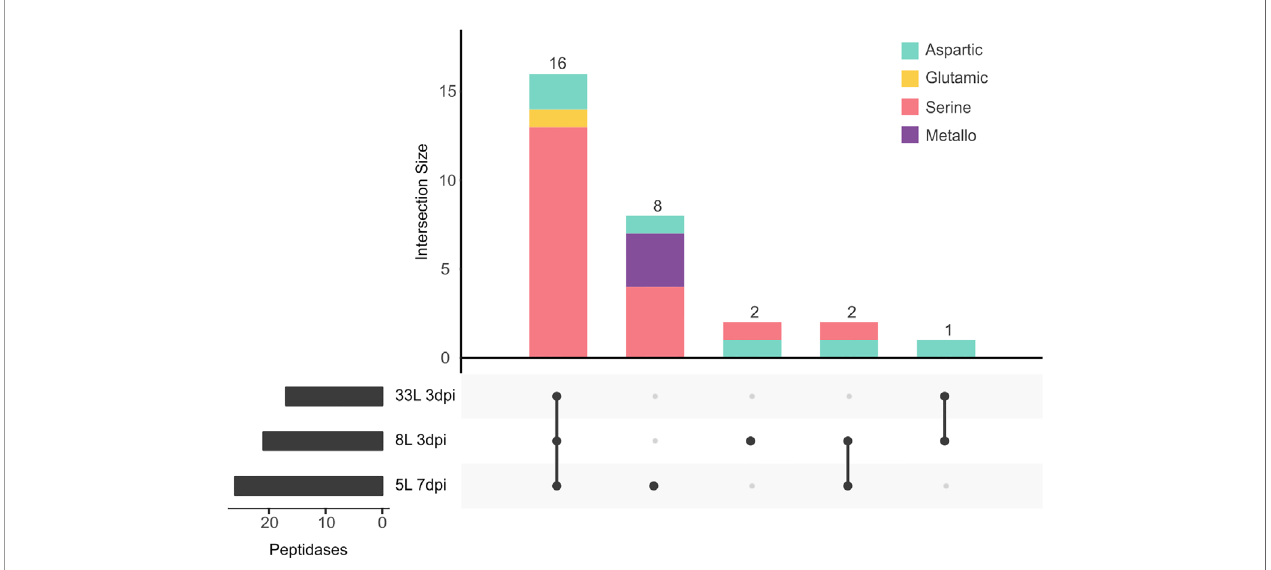
FIGURE 5 | UpSet plot of intersecting sets of peptidase proteins found in exoproteomes. Total identi fi cations for each sample (left bar chart), were 17 proteins for 33L and 21 proteins for 8L at 3 dpi, and 26 for 5L at 7 dpi. The connected dots among protein sets shown in the lower panel and numbers indicated in the top bar chart represent the group of proteins shared between exoproteome samples. The intersecting set (top bar chart) also classi fi ed the different peptidases according to the chemical mechanism as aspartic (green), glutamic (yellow), serine (pink), and metallo (purple) catalytic